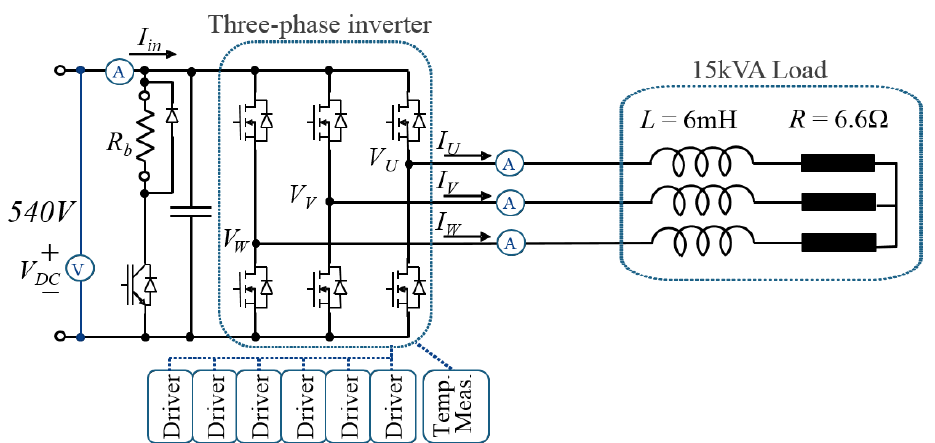
Figure 1. Basic three-phase inverter connected to a load with floating neutral-point, used as reference in calculation of semiconductor losses and built for a test platform.